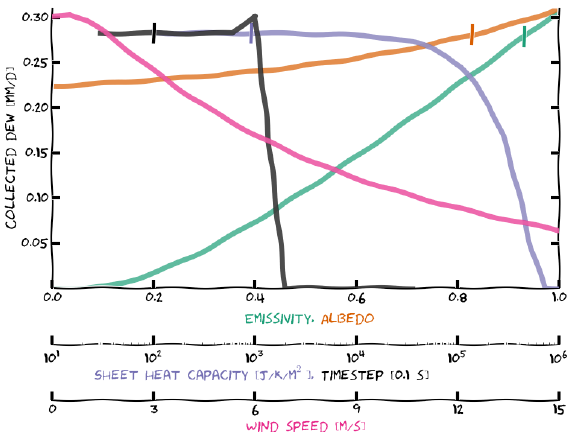
Figure 3. Sensitivity of the model to the emissivity, albedo and heat capacity of the condenser sheet as well as to the wind speed and time step of the model ( × 10 in figure). The heat capacity is defined here as C c ρ c S c δ c , i.e. its variation corresponds to varying any of these factors. The input data correspond to Table 1 and the first day of Fig. 1, where applicable. The vertical bars represent these default